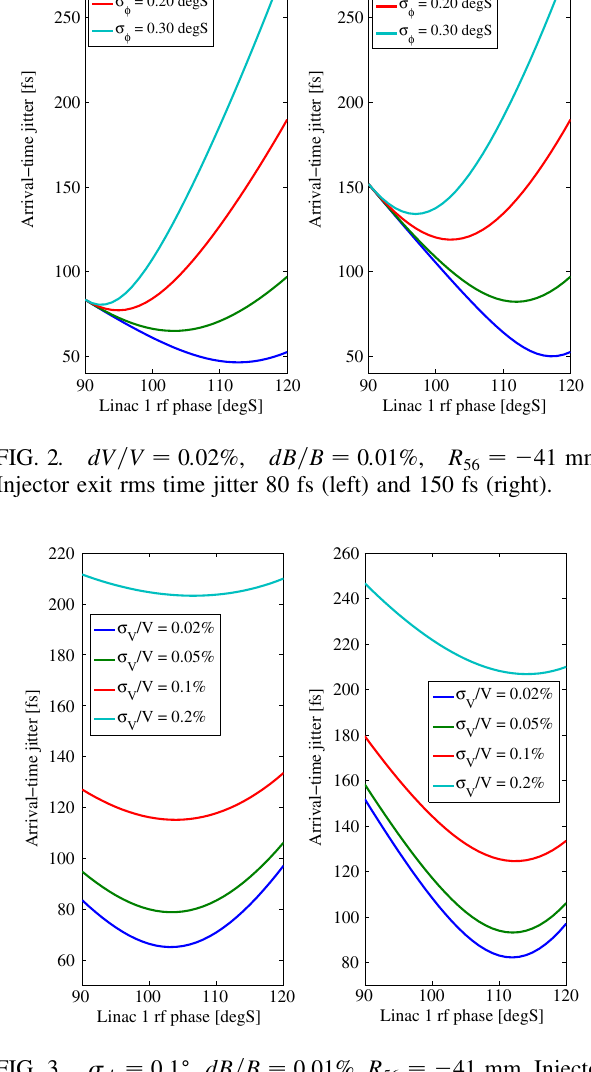
FIG. 3. (cid:5) (cid:1) ¼ 0 : 1 (cid:4) , dB=B ¼ 0 : 01% , R 56 ¼ (cid:3) 41 mm . Injector exit rms time jitter 80 fs (left) and 150 fs